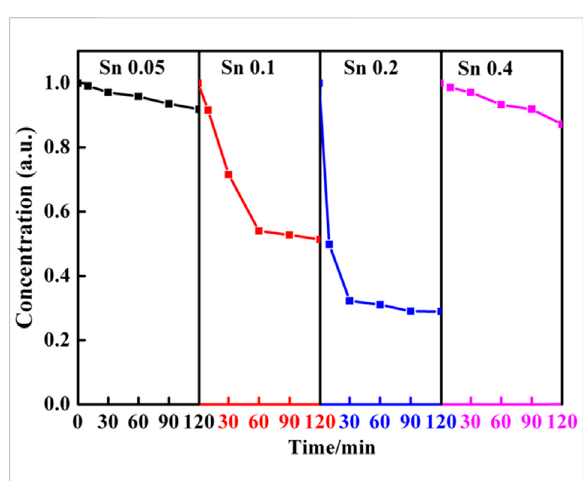
Dependence of the Sn-doped contents on the reaction time of Ti 1-x Sn x O 2 (0.05 ≤ x ≤ 0.4) compounds with RhB under visible- light